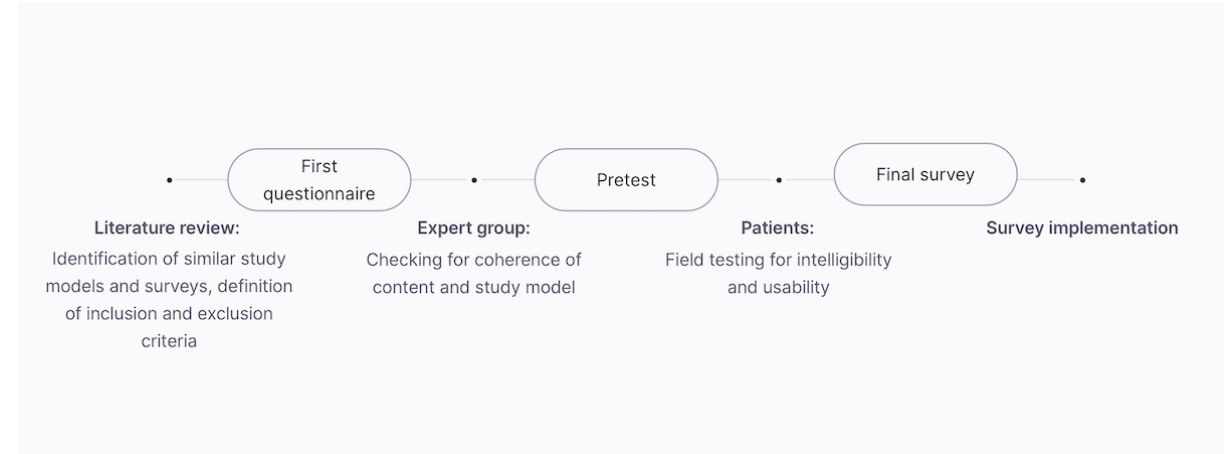
Figure 1. Schematic illustration of the survey development